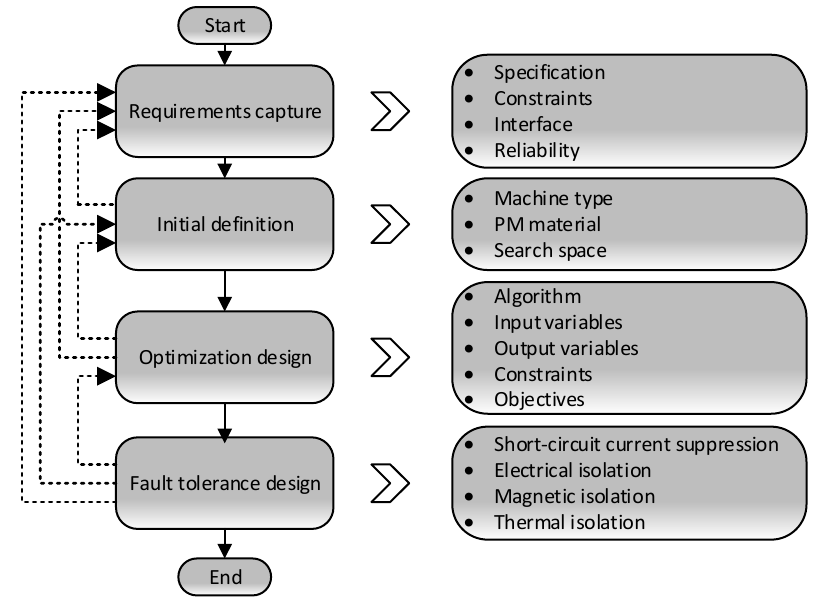
Figure 2. Design process of main phases and tasks.